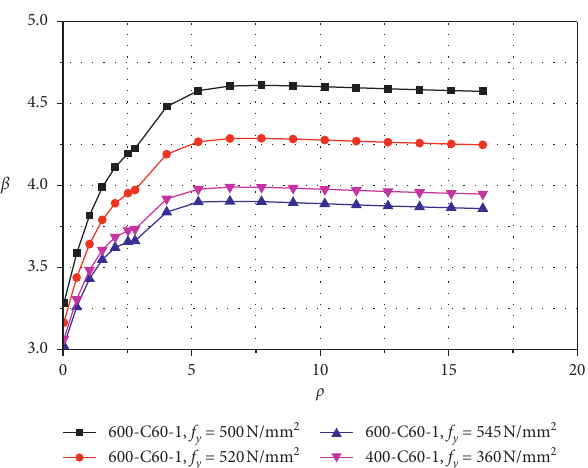
Figure 10: Comparison of the ρ - β variation curve of the test beam 600-C60-1 and 400-C60-1.